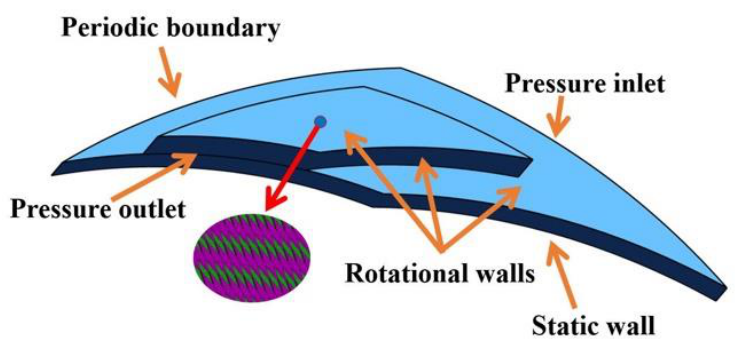
Figure 3. Boundary conditions of the lubricating film calculation domain.